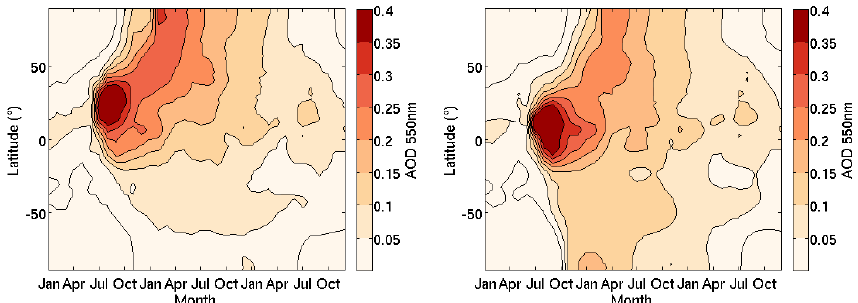
Figure A3. Zonal and monthly mean 550nm aerosol optical depth after volcanic eruption in (a) Volc1 simulation and (b) Volc5 simulation.